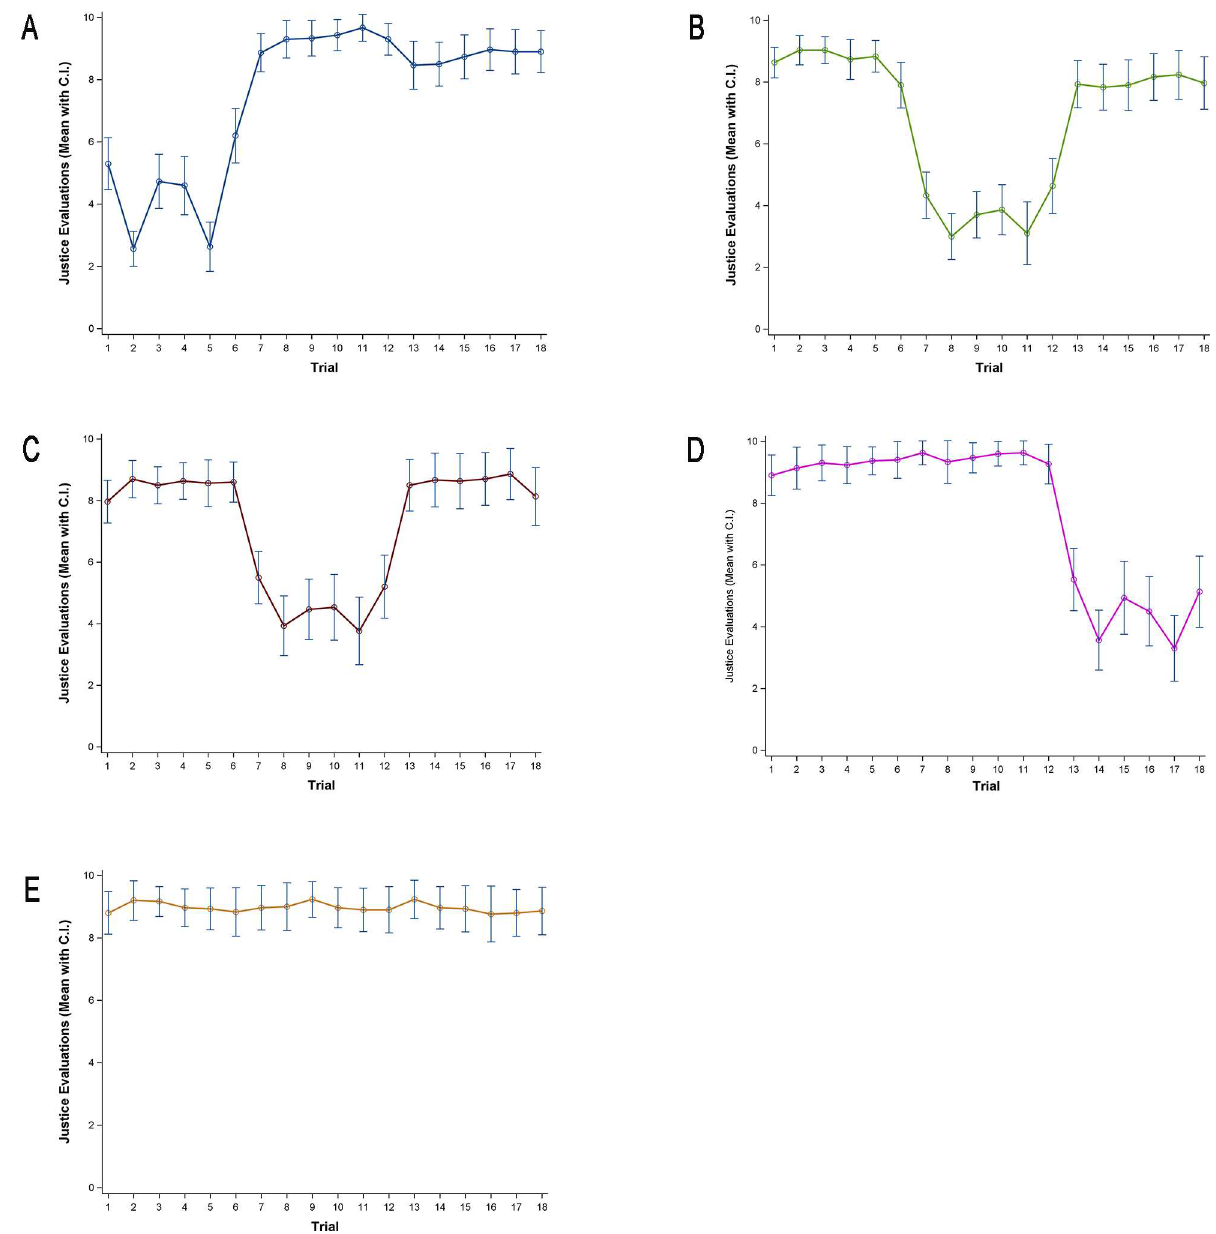
Fig 2. Justice Evaluations by Trials. Each panel presents justice evaluation levels in (A) Under-Reward/Primacy Condition, (B) Over- Reward/Primacy, (C) Under-Reward/Recency Condition, (D) Over-Reward/Recency Condition, and (E) Control Condition. In all graphs, the horizontal axis indicates“Trial” and the vertical axis indicates “Justice Evaluations (mean with 95% confidentialinterval)”. Fig 3 show the asymmetric tendency more clearly. The justice evaluations across different reward levels show a negative effect of under-rewards (p < .001 for all under rewards), and a positive effect of over-rewards (when over-rewarded by 10% the difference is not significant (p = .106), when over-rewarded by 20% or 30%, p < .01) on justice evaluations. This result rep- licates prior research on asymmetries in justice evaluations, with under-reward being experi- enced more profoundly than over-reward [15, 28].